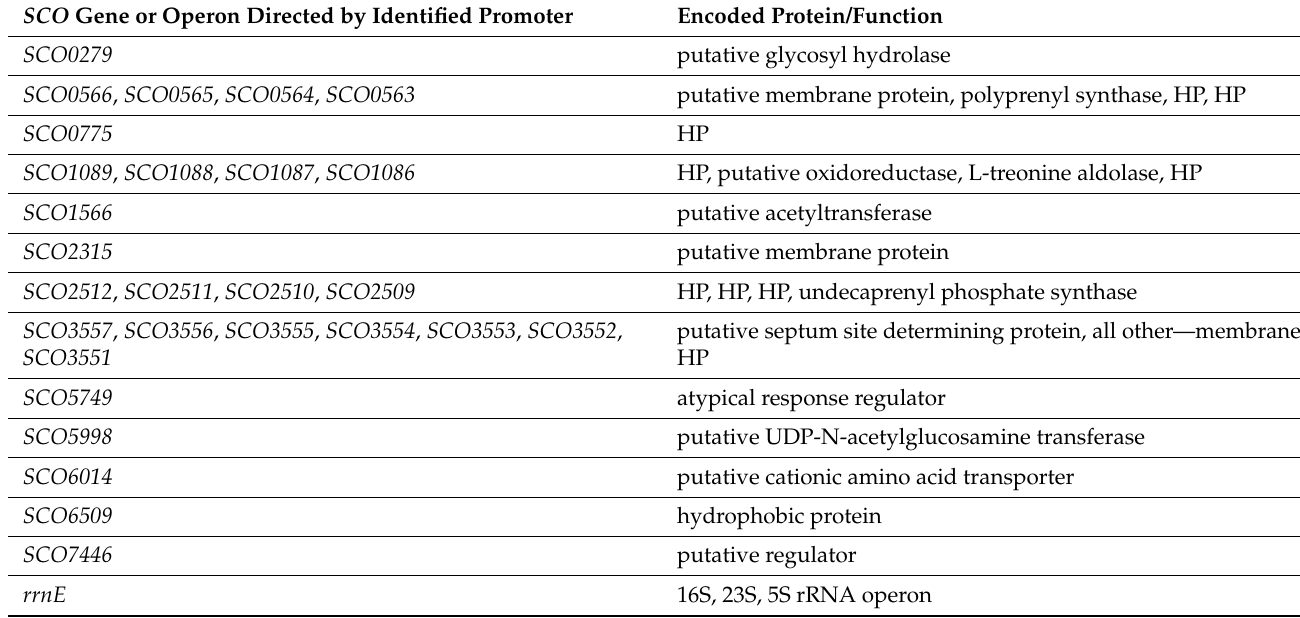
Table 1. List of identified SigB-dependent genes from S. coelicolor A3(2) and their proposed function. SCO Gene or Operon Directed by Identified Promoter Encoded